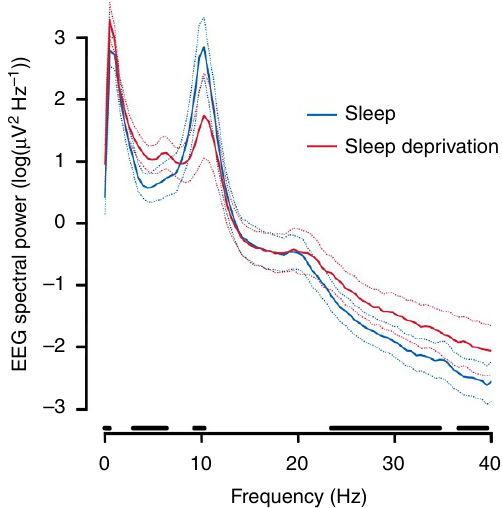
Figure 2 | Electroencephalographic (EEG) spectral power. After sleep deprivation, power density in the 3.5–8Hz (theta) frequency range was significantly higher compared with the sleep condition ( P o 0.05). Exploratory analyses revealed condition effects in other frequency ranges. Solid lines represent means ( n ¼ 20). Dashed lines represent 95% confidence intervals. Paired-sample t -tests were used (two-tailed). Horizontal lines indicate significant condition effects ( P o